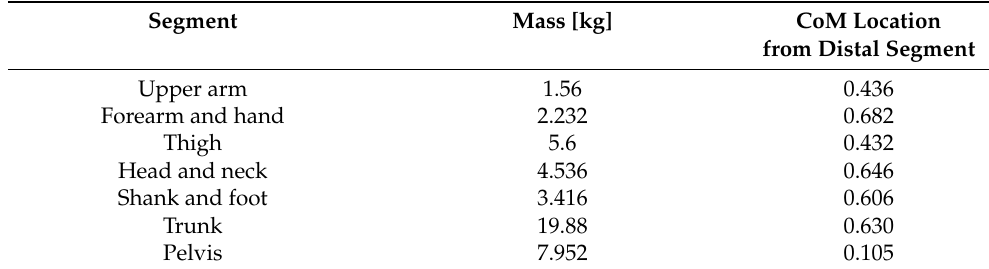
Figure 1. Visualization of markers in Mokka software ( left ) and reconstructed stick diagram of a human body ( right ). Table 2. The anthropometric